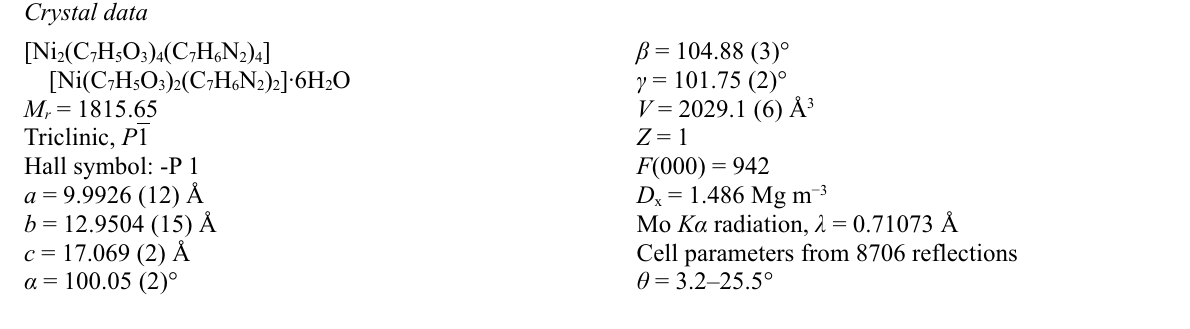
A diagram showing π - π stacking between bzim ligands [symmetry code: (iii) 1 - x ,1 - y ,1 - z ]. Bis( µ -3-hydroxybenzoato)- κ 2 O 1 : O 3 ; κ 2 O 3 : O 1 -bis[bis(1 H - benzimidazole- κ N 3 )(3-hydroxybenzoato- κ O